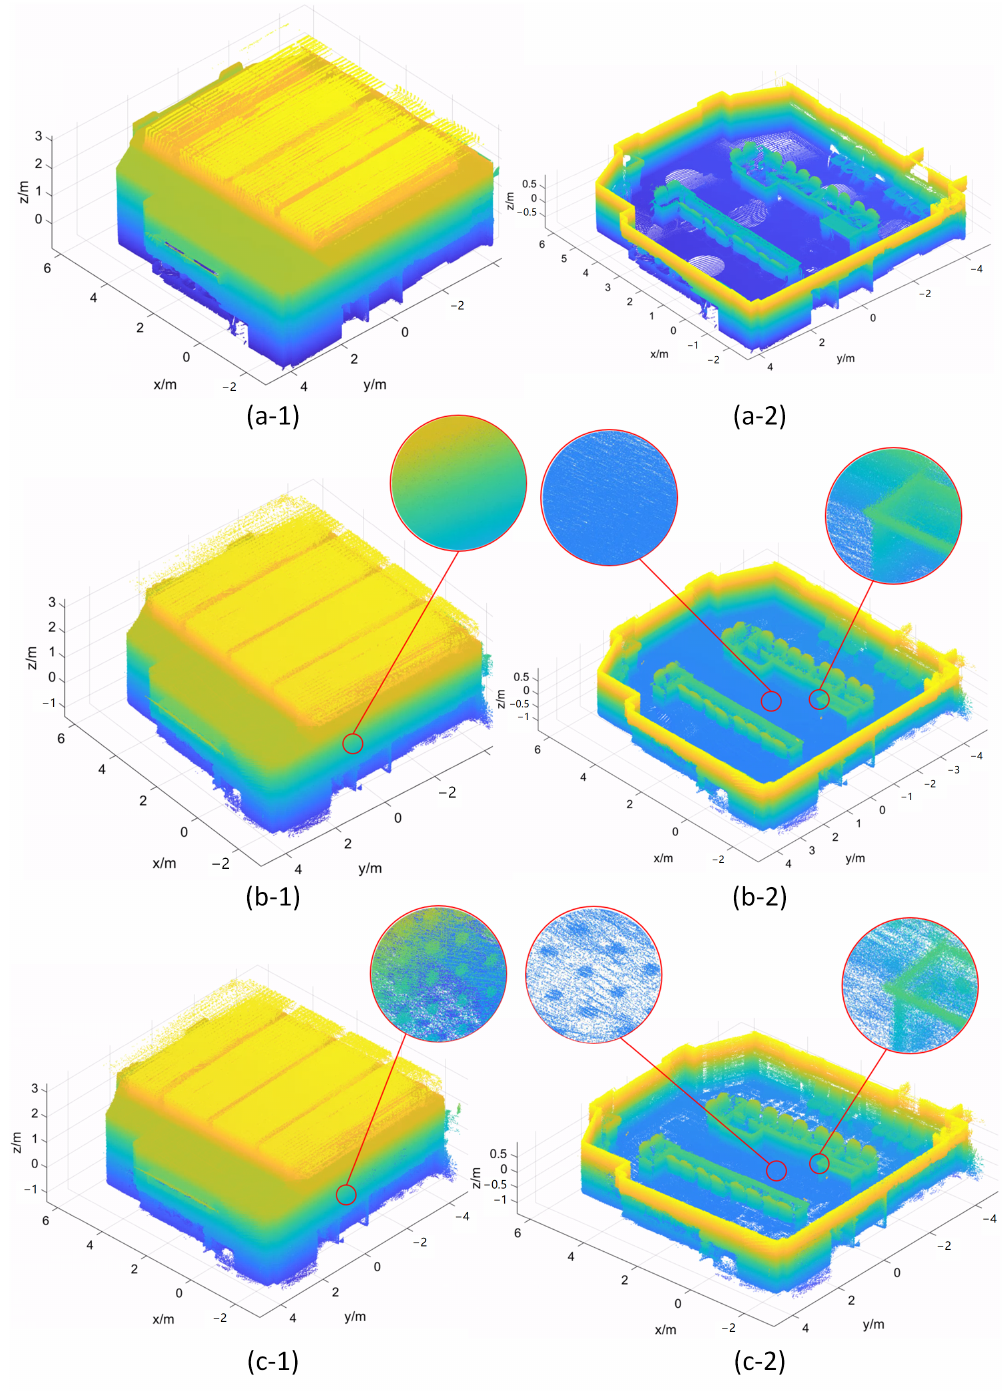
Figure 13. The result of the conference room environment mapping experiment (colored by depth). ( a-1 , a-2 ) show the ground truth. ( b-1 , b-2 ) show the mapping result without variable resolution strategy. ( c-1 , c-2 ) show the mapping result with variable resolution strategy. The full map is on the left and the interior details are on the